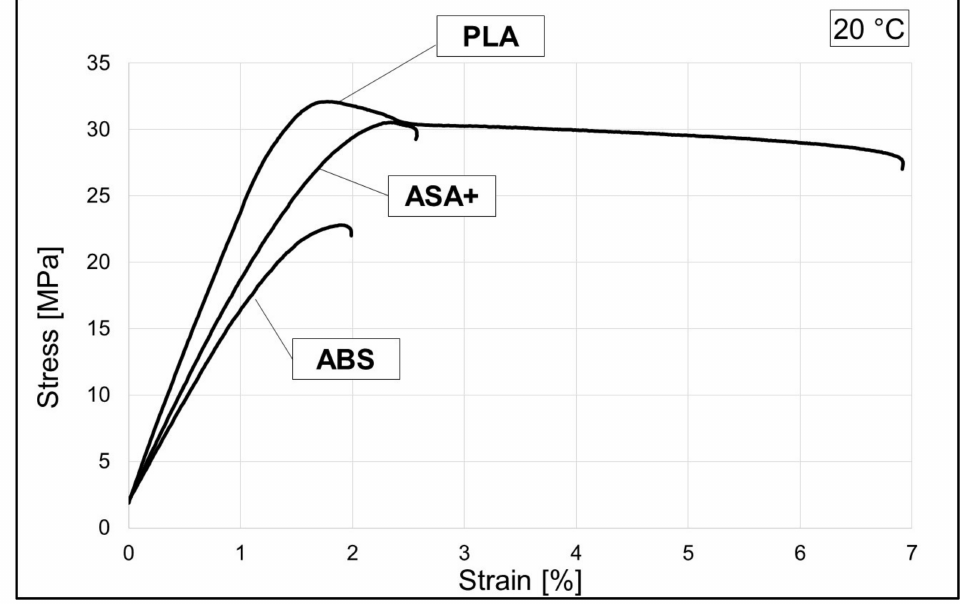
Figure 1. Engineering stress–strain diagrams at room temperature for polylactide (PLA), acrylonitrile